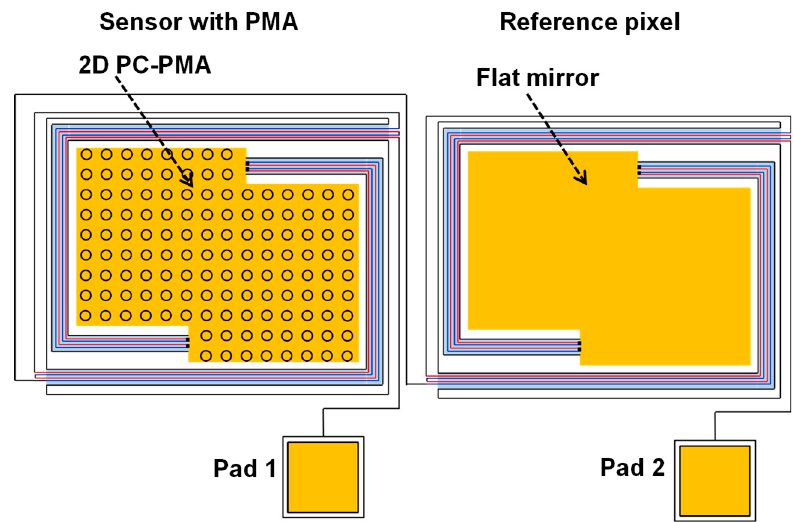
Figure 4. Schematic illustration of the sensor with 2D PC-PMA and the reference pixel, in which the output signal was produced from the subtraction operation between them.